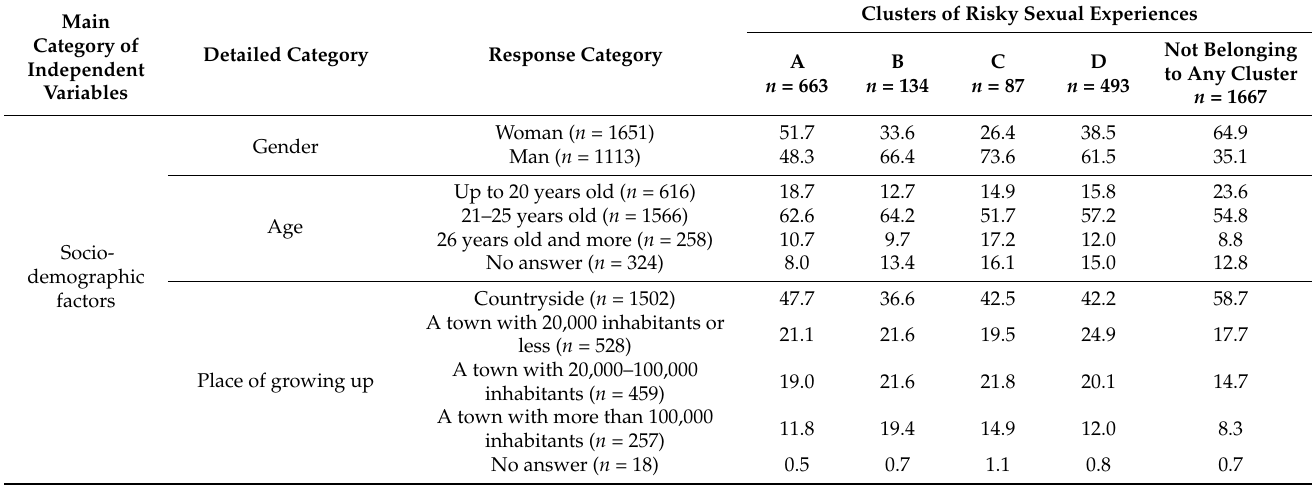
Table A3. Cluster membership by selected characteristics of respondents (% in a cluster) ( n =